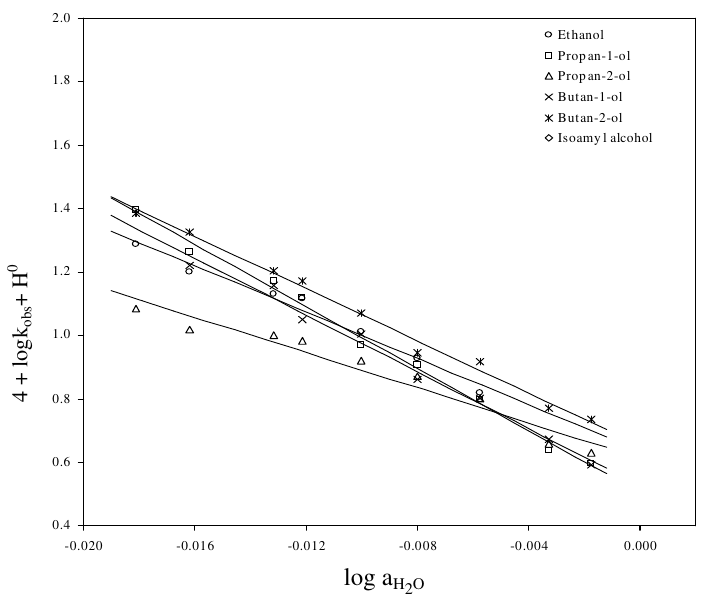
Figure 7. Bunnett plots in perchloric acid media.